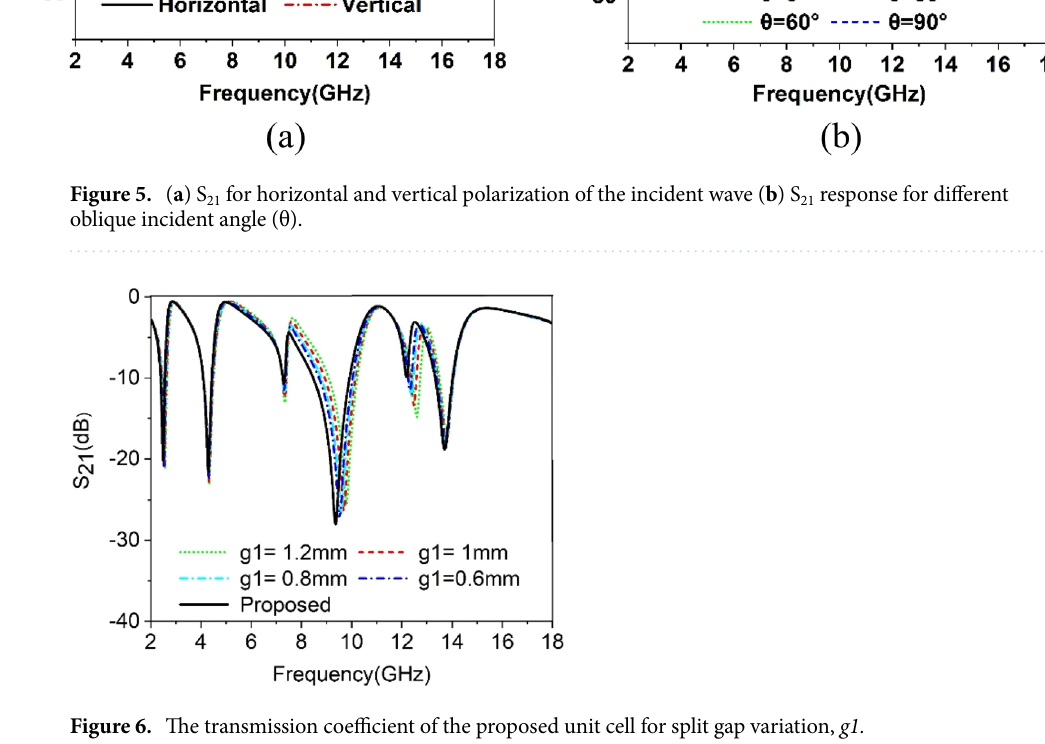
Figure 6. The transmission coefficient of the proposed unit cell for split gap variation,